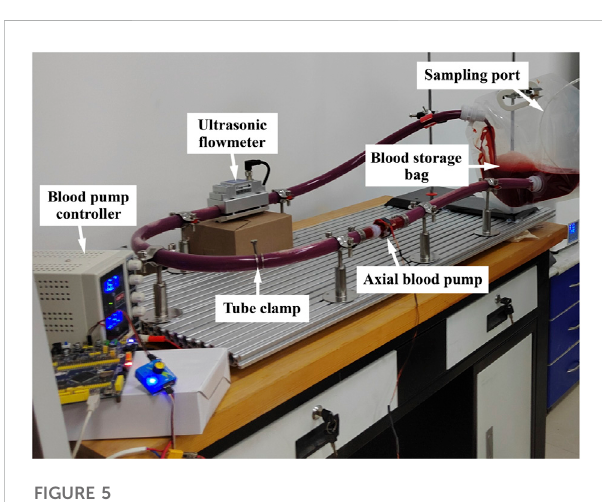
FIGURE 5 Hemolysis test circulation